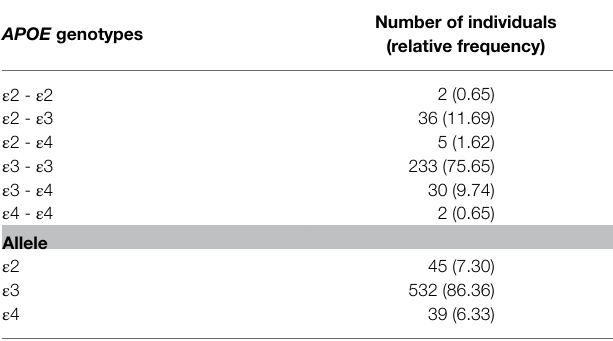
TABLE 2 | Genotypic and allelic frequencies of APOE polymorphism in the sample analyzed (N308). APOE